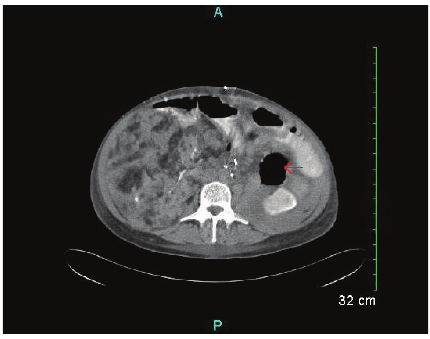
Figure 3: Transverse section of CT abdomen-pelvis after left nephrectomy (indicated by